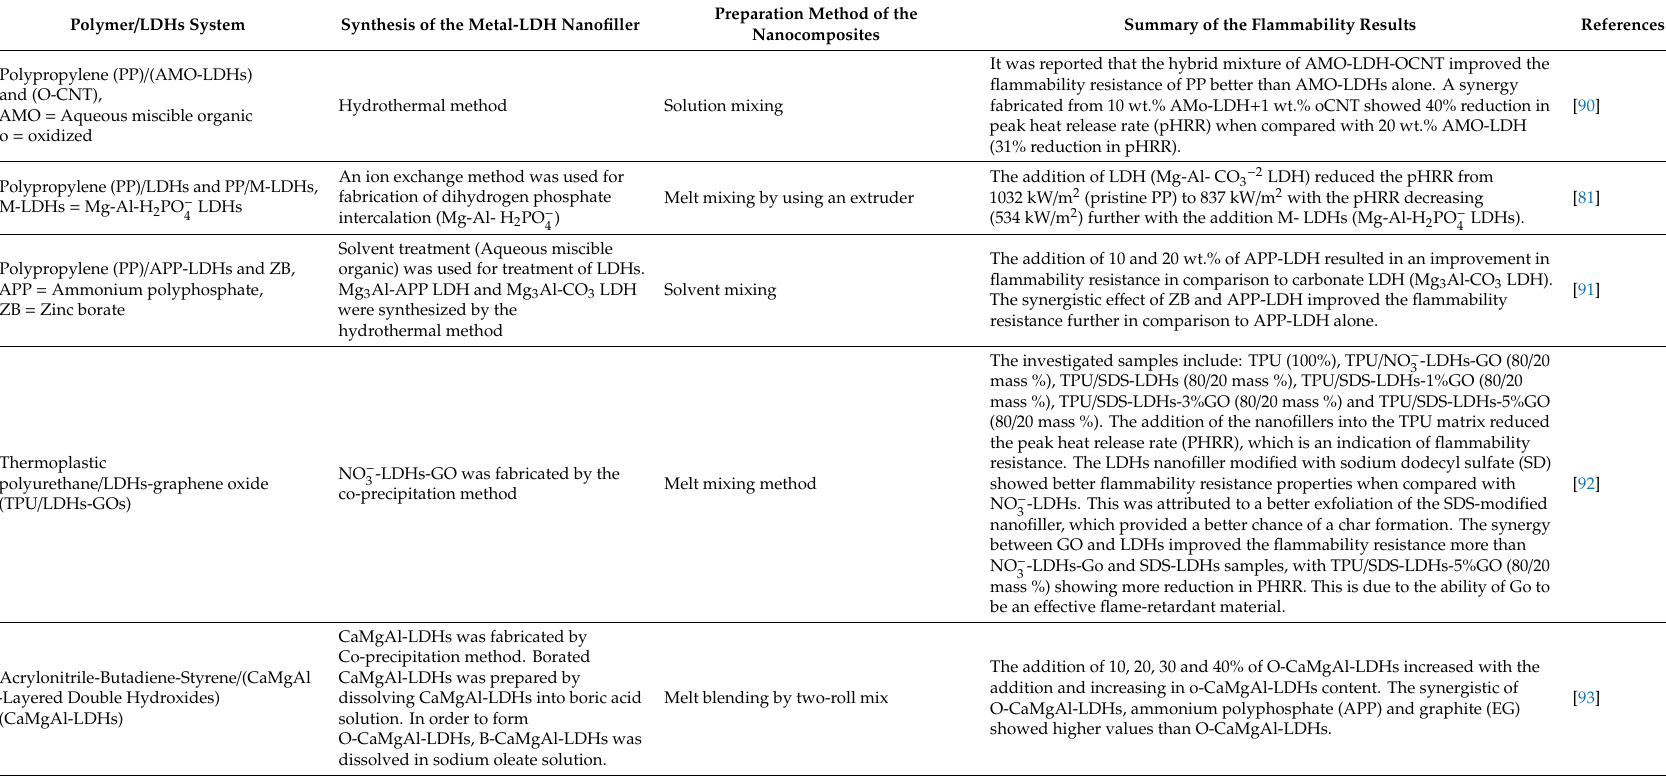
Table 3. Selective studies on the flammability properties of a polymer / LDHs